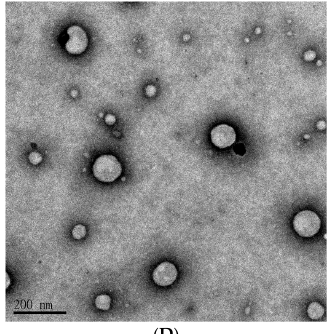
Figure 1. ( A ) A schematic diagram for the preparation of PEGylated liposomal delivery system of SUV-Mal and SUV-RF. Particle size distribution and ζ potential of PEGylated liposomes of: ( B ) SUV- G+T (SUV-GSH + Tween 80); and ( C ) SUV-RF. Transmission electron microscopic image of PEGylated liposomes of ( D ) SUV-RF. Bar = 200 nm.